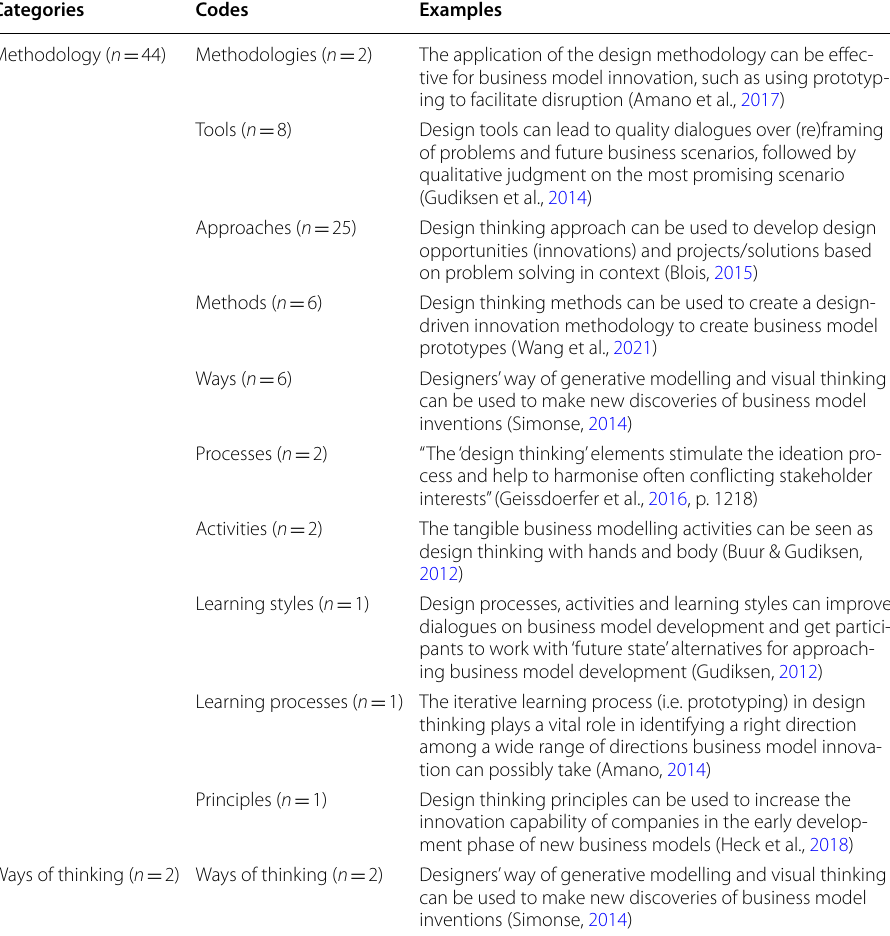
Table 5 Results of coding on the value of design thinking for business model innovation